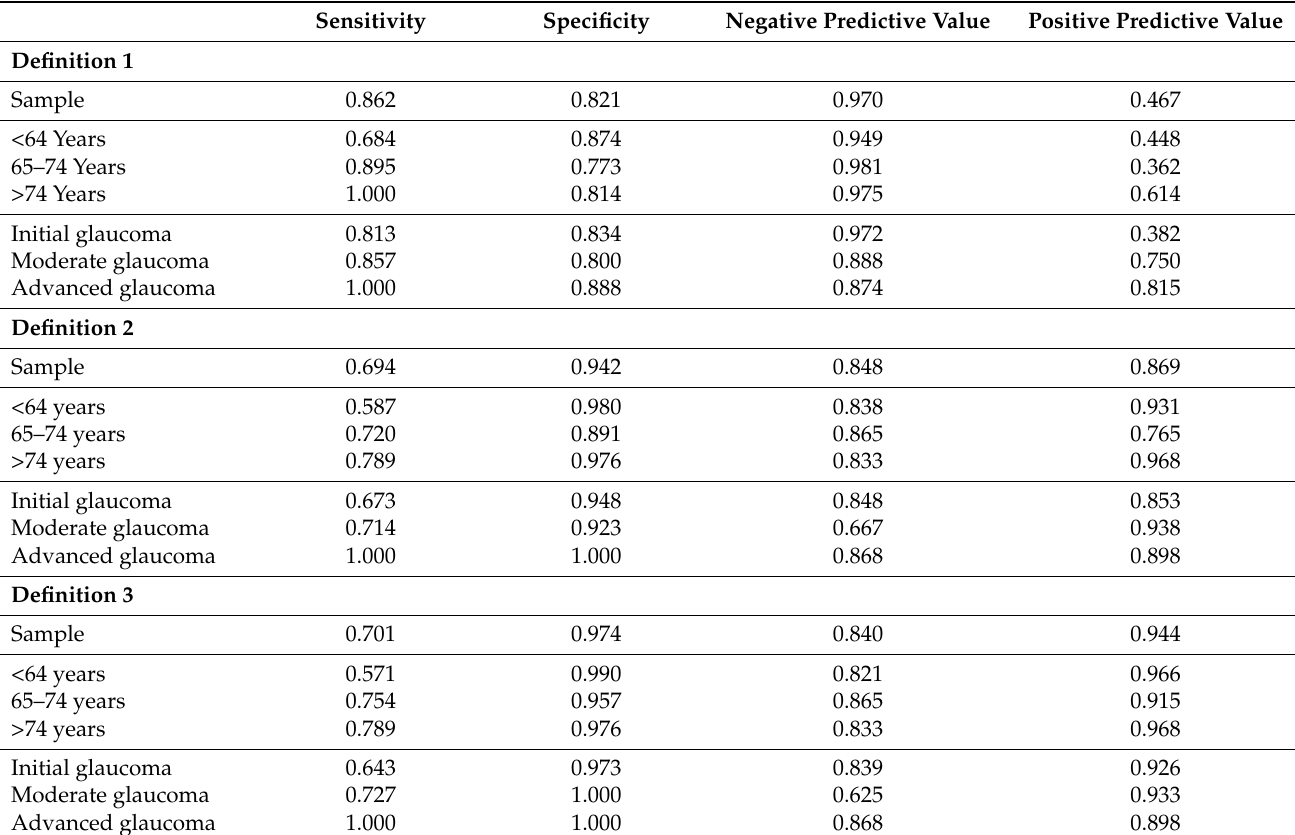
Table 3. Diagnostic accuracy of screening program for detecting